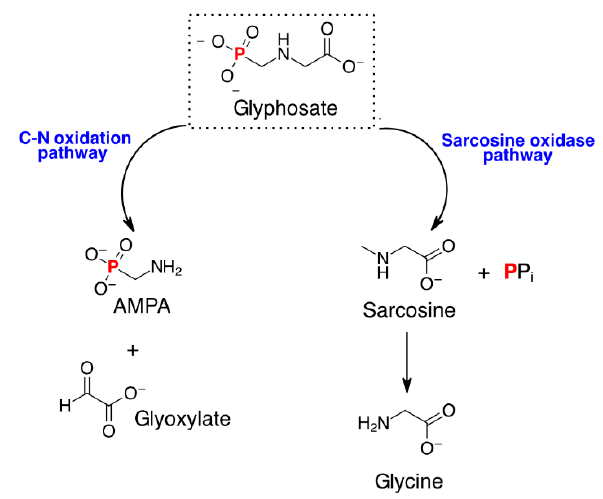
Figure 1. Biochemical pathways of glyphosate degradation by C-N oxidation and sarcosine oxidase.